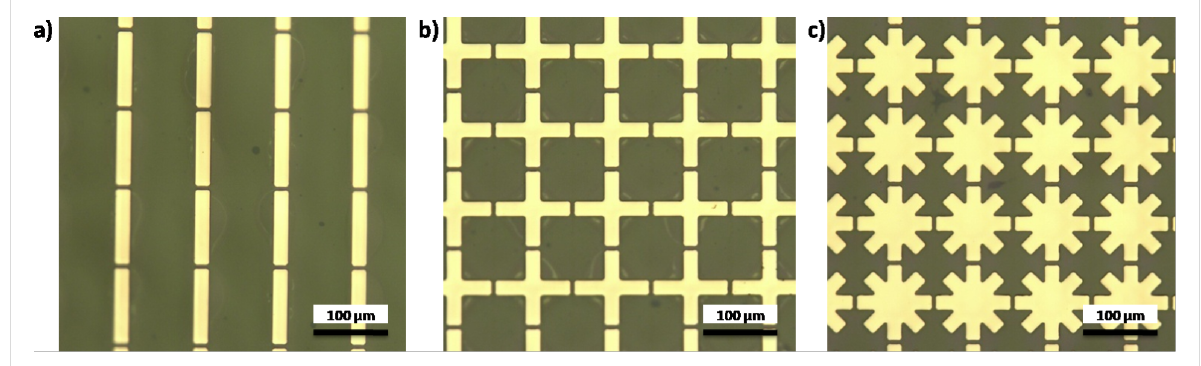
Figure 2: Microscopy images of the fabrication samples: a) Cut-wire sandwich structure, b) cross-shaped sandwich structure, and c) star-shaped sandwich structure.